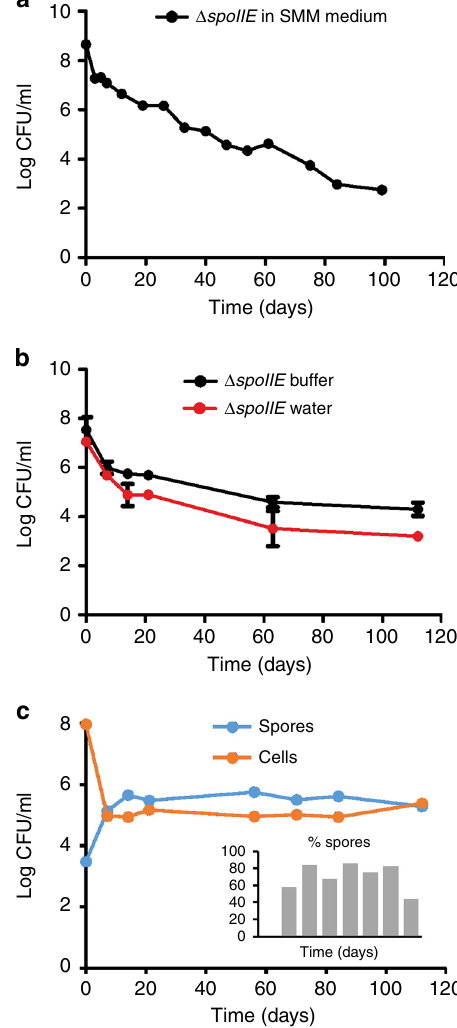
Fig. 1 Long-term survival of non-sporulating B. subtilis. a Colony-forming units (CFU) of B. subtilis Δ spoIIE (strain DG001) incubated in Spizizen minimal medium (SMM). b CFU of Δ spoIIE cells that were fi rst grown for 2 days in SMM, and subsequently fi ltered and incubated in either starvation buffer or water ( = 0 days time point). The CFU numbers of the fi rst time point are therefore comparable to those of time point 2 days in graph ( a ). Averages and standard deviation from three independent experiments are depicted. The difference between the two graphs becomes signi fi cant after day 7 ( p < 0.05, unpaired two-tailed t -test). c CFU of spores and cells in a wild-type B. subtilis culture (strain BSB1) incubated in starvation buffer. The percentage of spores is indicated in the bar diagram. Results of two replicate experiments are shown in Supplementary Figure 2A. See Methods for details on growth and starvation